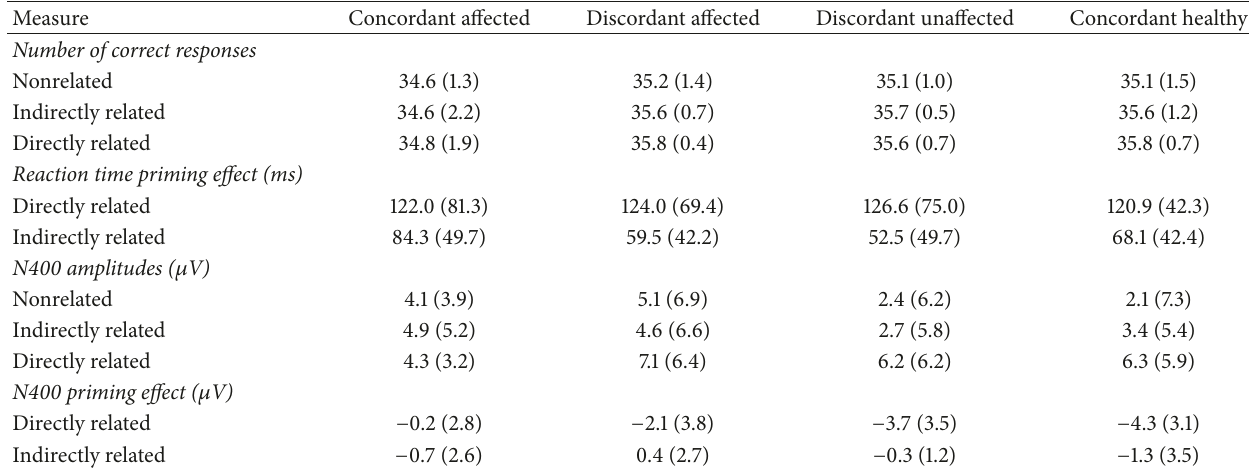
Table 3: Behavioral and EEG measures: mean values (standard